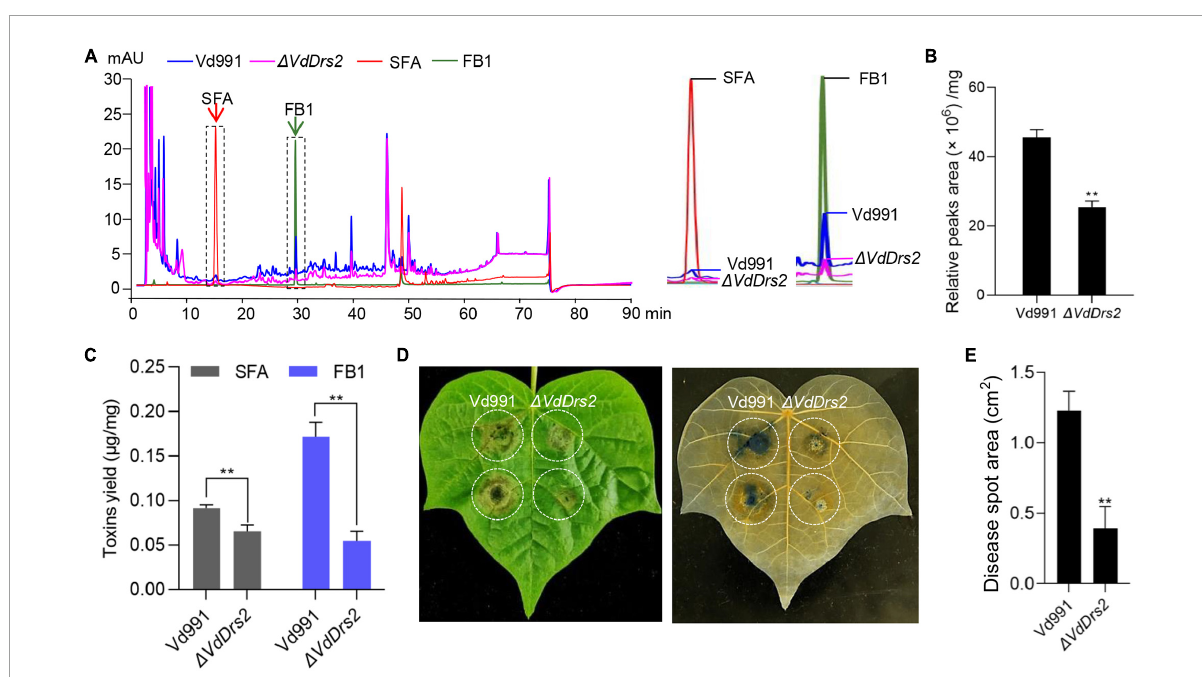
FIGURE6 Disruption of VdDrs2 decreases the amount of secondary metabolites in fermentation broth of V. dahliae and reduced the toxicity of the crude extraction to cotton leaves. (A) High-performance liquid chromatography (HPLC) profile of metabolites from Vd991 and (cid:49) VdDrs2 . Authentic sulfacetamide (SFA) and fumonisin B1 (FB) were included to show the presence of these compounds in the fermentation broths. SFA, sulfacetamide; FB1, fumonisin B1. (B) Total peaks area of metabolites produced per mg fungi to show (cid:49) VdDrs2 fermentation were lower than those of Vd991. (C) Production of SFA and FB1 was decreased in (cid:49) VdDrs2 compared to Vd991. The amount of the each toxin produced by one mg fungi was determined with standard curve of SFA and FB1 ( µ g toxin/mg fungi). ** P < 0.01. The value is the mean of three separate determinations. (D) Disease symptoms of cotton leaves after inoculation with crude toxins produced by Vd991 and (cid:49) VdDrs2 . Trypan blue staining was used to detect area of cytolysis (right). (E) Statistical analysis of the area of toxin-poisoned tissue per square centimeter. cm 2 : per square centimeter. Disease spot area was measured using ImageJ software. Two groups of data were compared using t tests in SPSS. ** P < 0.01. All experiments were performed in